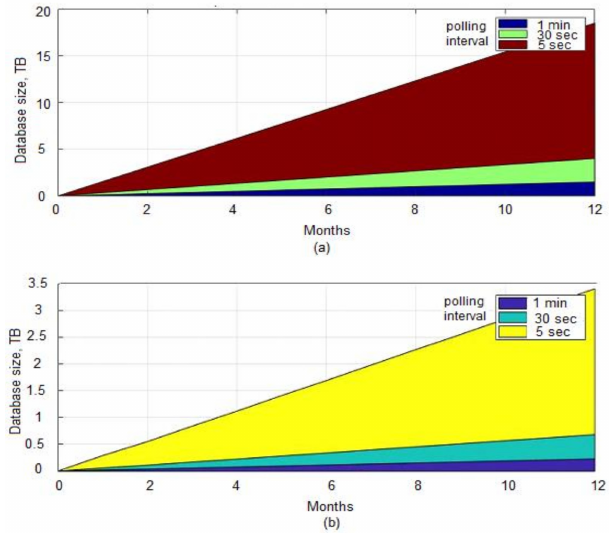
Figure 11. Database size ( a ) Ceilometer ( b )